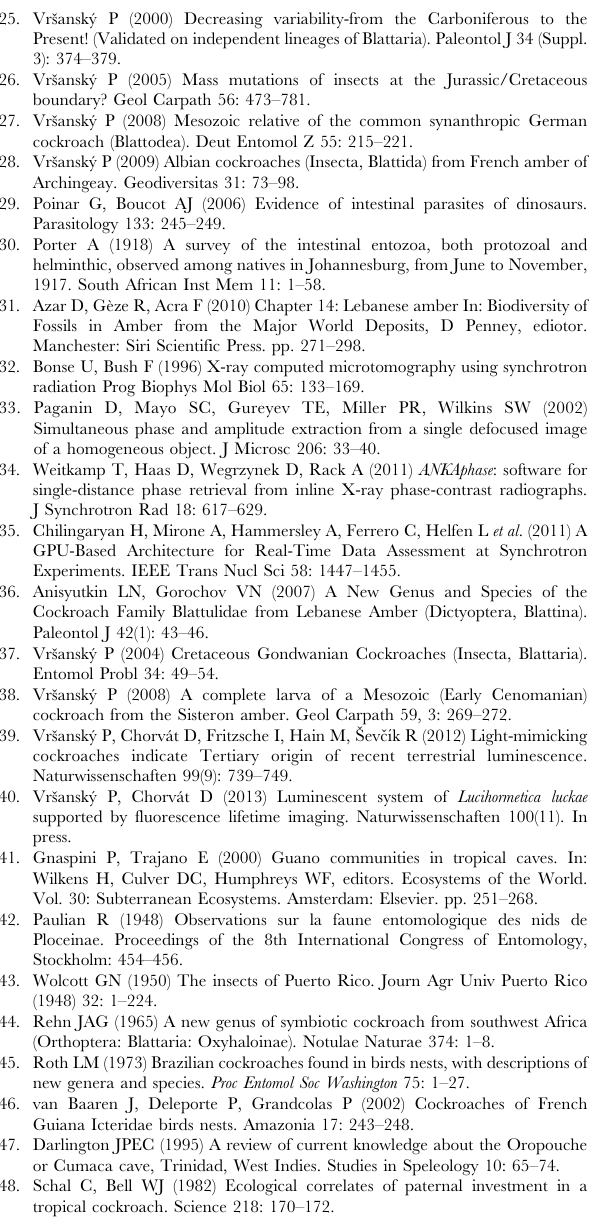
Figure S1 Synchrotron imaging of 5 coprolites of dinosaur-age immature cockroach from the Lebanese amber (Blattulidae 1094A-I). Select transparent mode for 3D visualization and